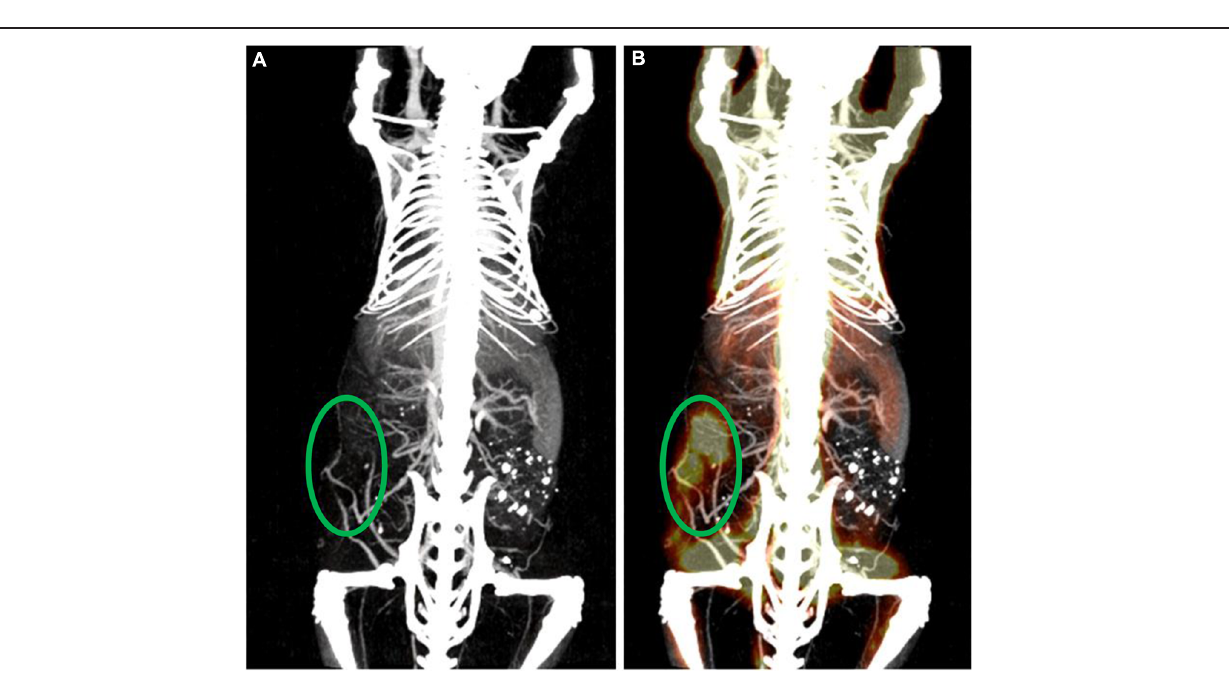
gold nanoparticles conjugated to both glucose and 18 F-FDG